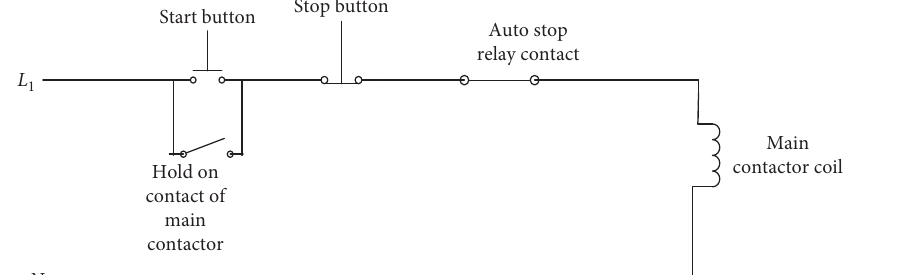
Figure 2: Line diagram of the induction control unit.